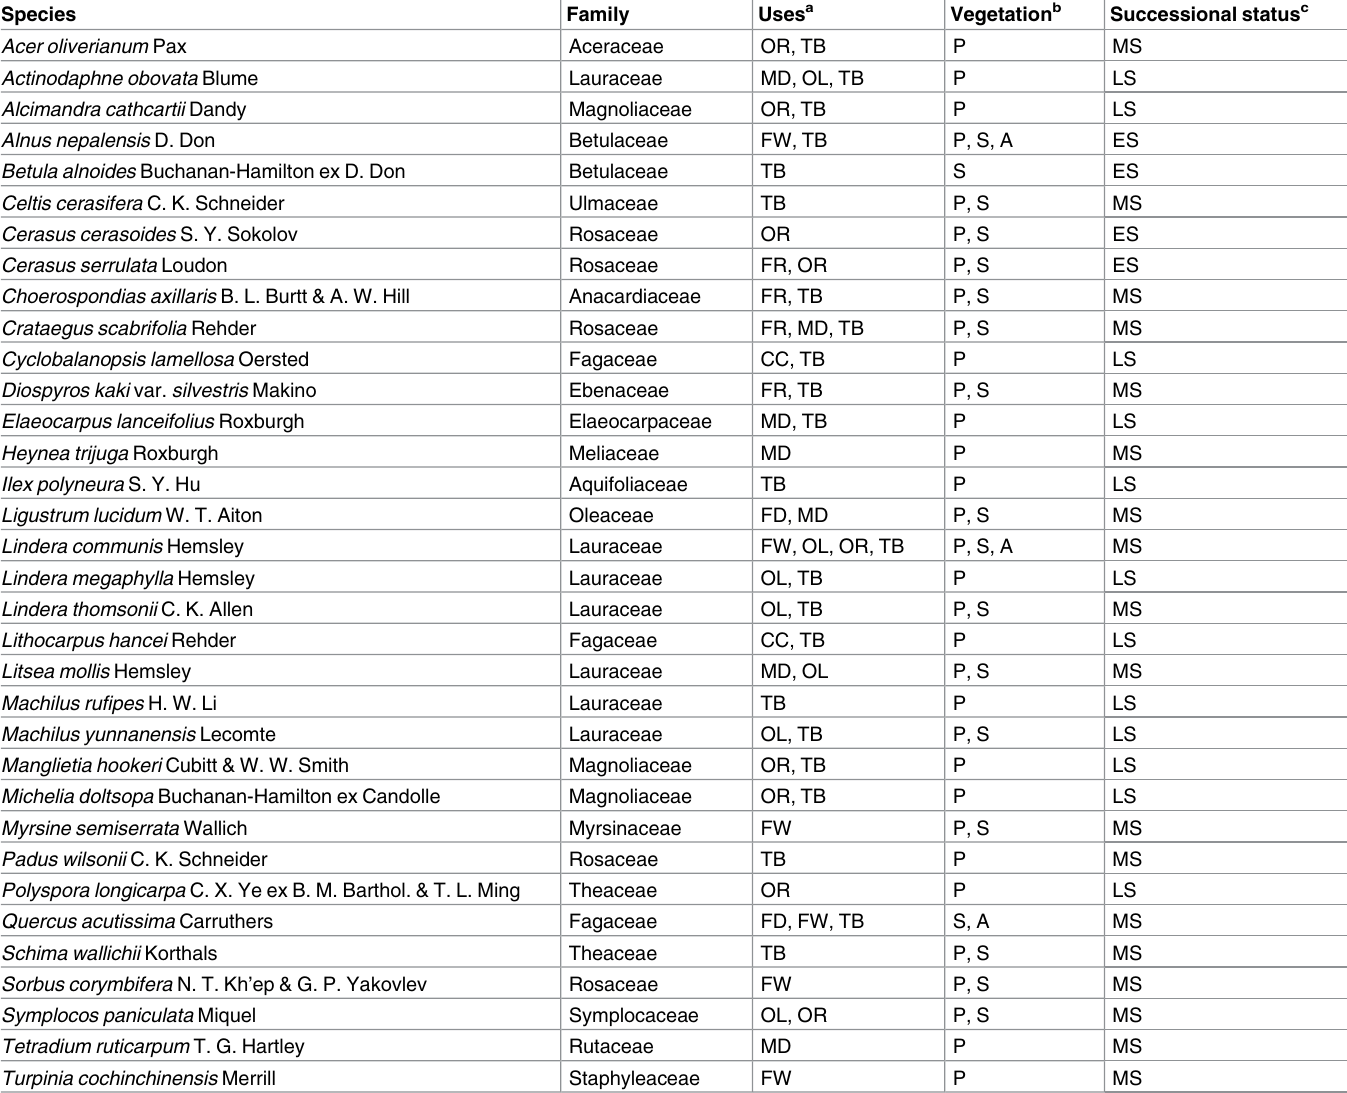
Table 1. Information on 34 native tree